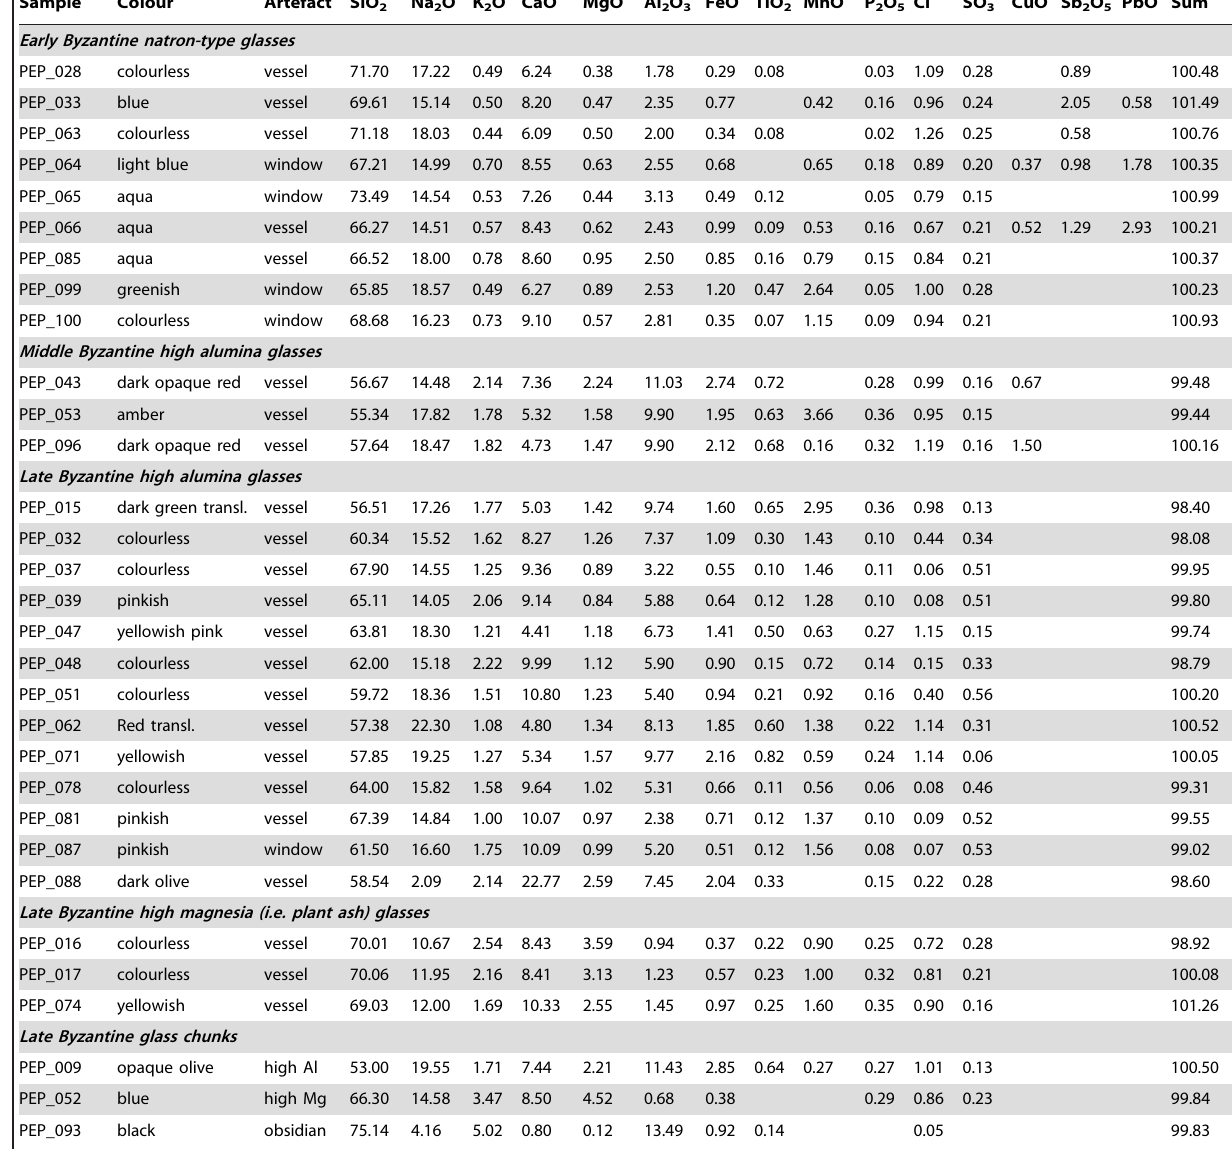
Table 1. Results from the EPMA analysis (n $ 5; values given in wt% of oxides) divided into chronological and chemical sub-groups.